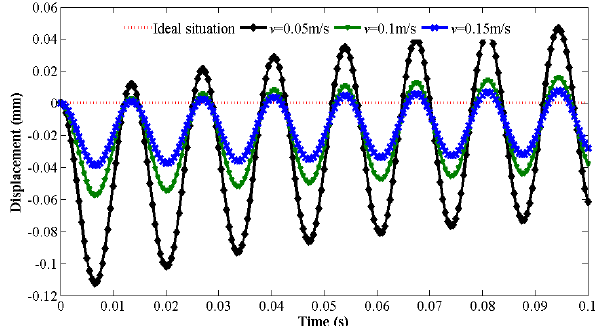
Figure 4. Vibration responses of the MDFMS under different mo- tion velocities.